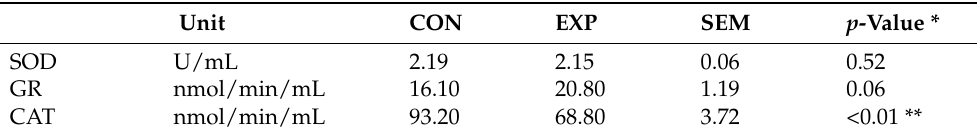
Table 2. The activity of antioxidant enzymes in the ruminal fluid in the control and experimental group.